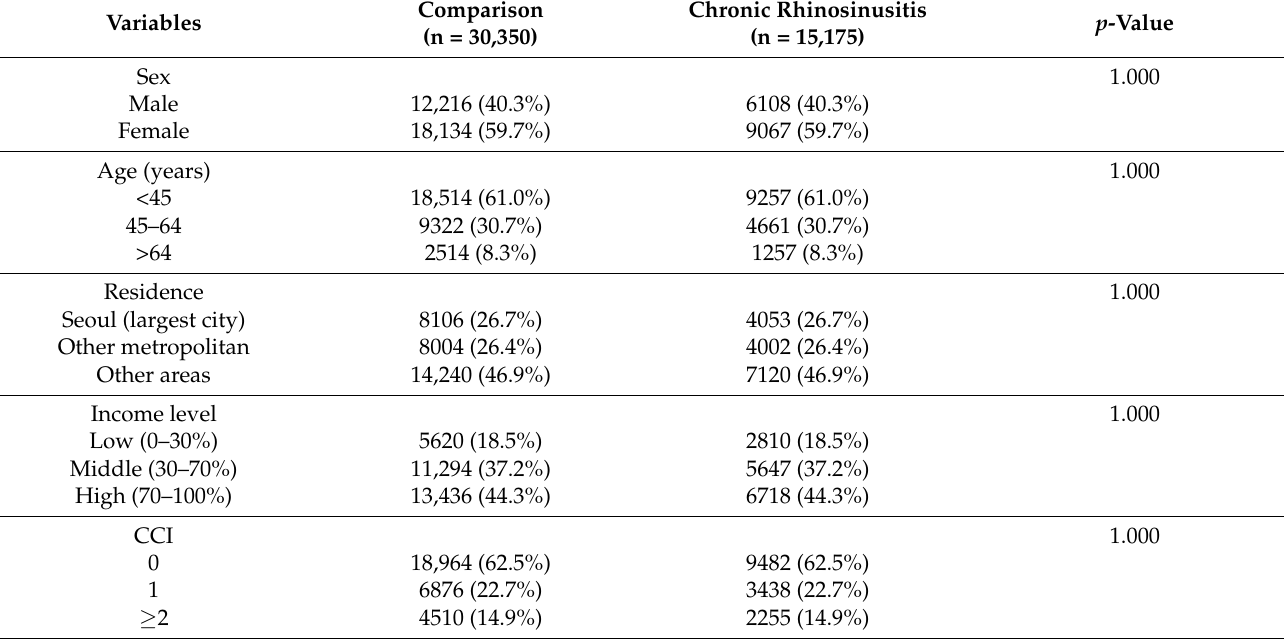
Table 1. Detailed characteristics of each cohort dataset.